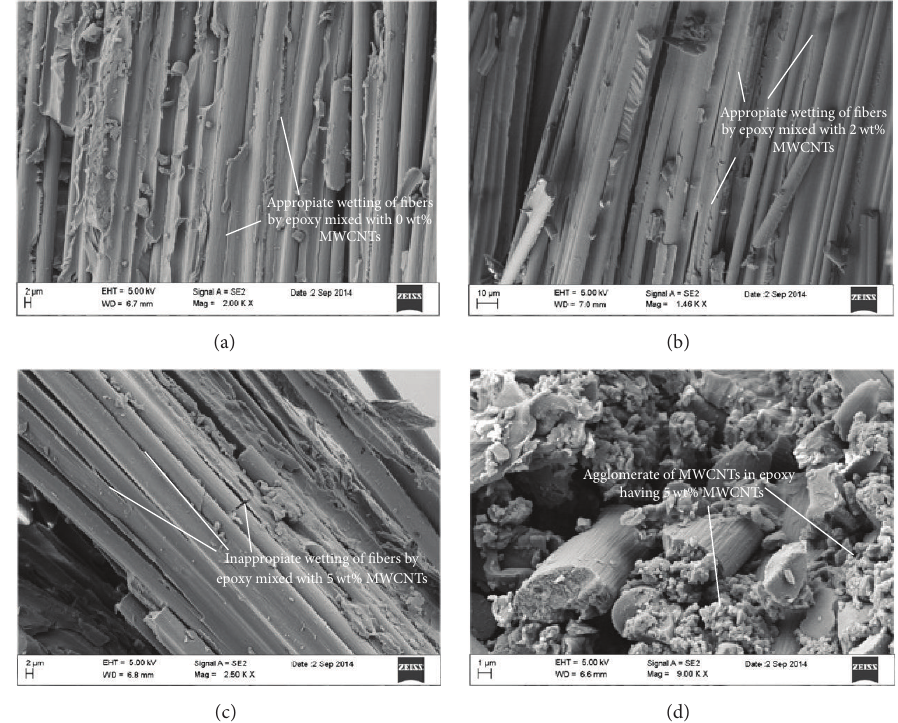
Figure 4: FE-SEM image of interface of fiber and epoxy mixed with (a) 0wt.% MWCNTs, (b) 2wt.% MWCNTs, (c) and 5 wt.% MWCNTs and (d) showing agglomeration of MWCNTs in laminate having 5wt.% MWCNTs in epoxy.